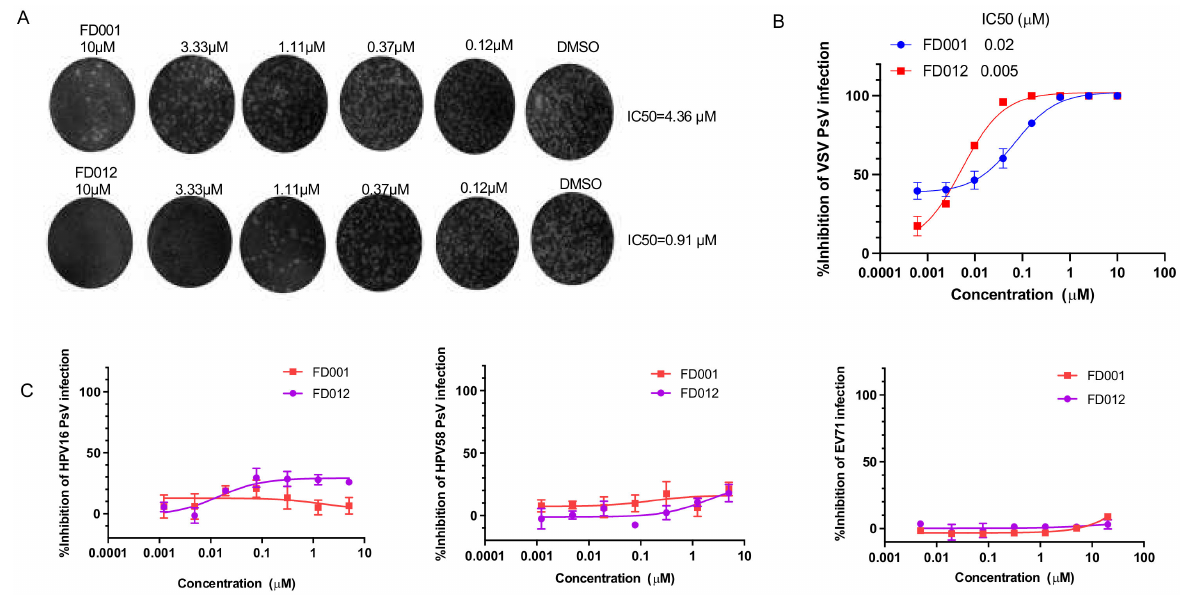
Figure 3. FD-compounds inhibited infection of enveloped viruses with class II and III viral fusion protein, but not nonenveloped viruses. ( A ) FD001 and FD012 inhibited authentic ZIKV PRVABC59 (2015/Puerto Rico) infection in Vero E6 cells; ( B ) FD001 and FD012 inhibited VSV PsV infection in Huh-7 cells; ( C ) FD001 and FD012 could not inhibit infection of the nonenveloped HPV PsV in Hela cells and authentic EV71 in RD cells. Data are means ± SD of triplicate samples from a representative